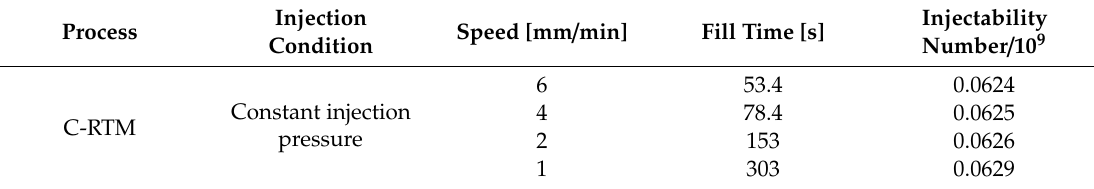
Table 7. Fill times and injectability numbers for C-RTM simulations of the second hood geometry at di ff erent compaction speeds.